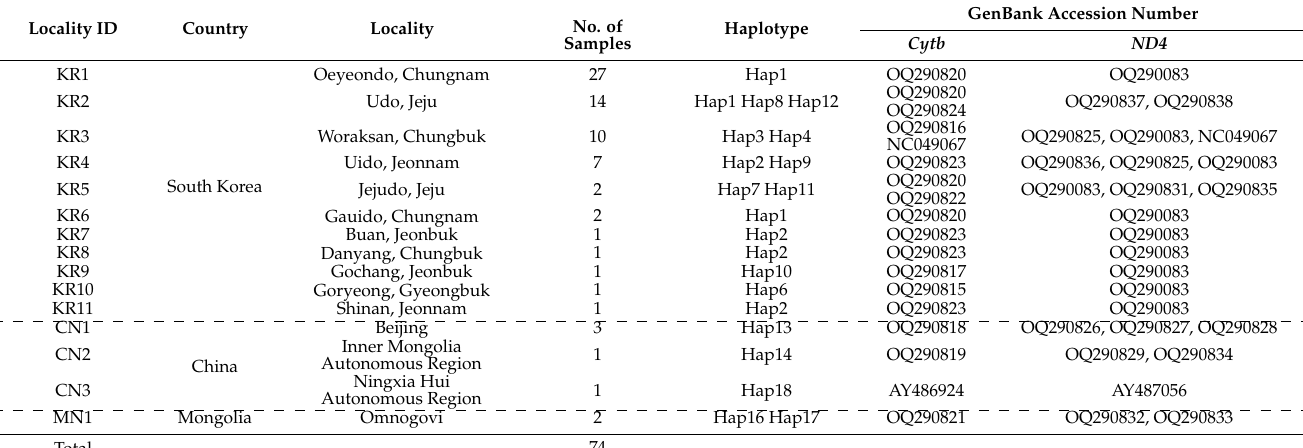
Table 1. Sampling information of Orientocoluber spinalis collected from South Korea, China, and Mongolia. Haplotypes are based on the concatenated sequence of mitochondrial Cytb (1113 bp) and ND4 (696